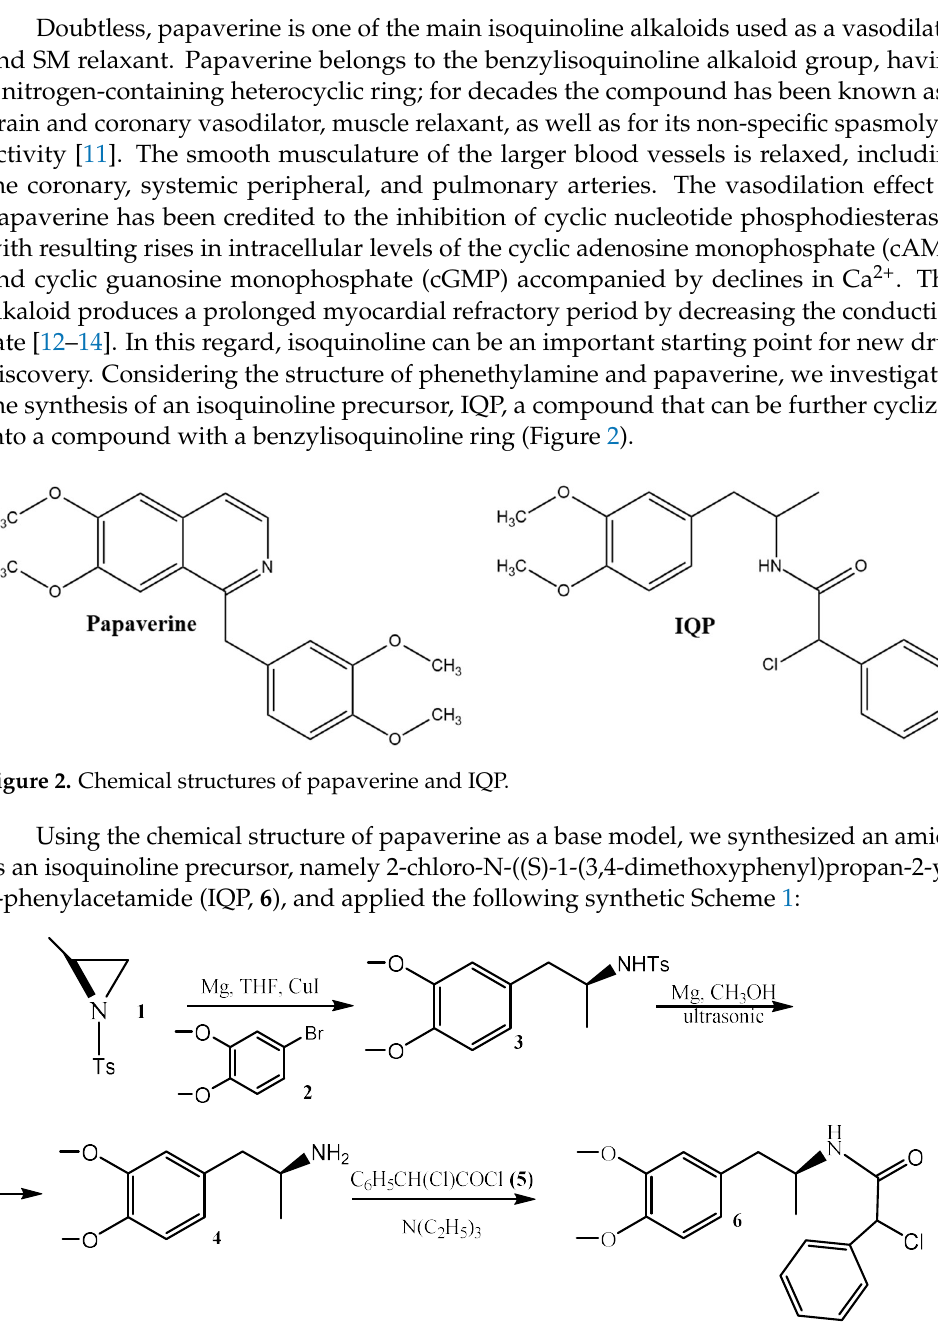
Figure 1. Chemical structures of 5-HT and phenethylamine.